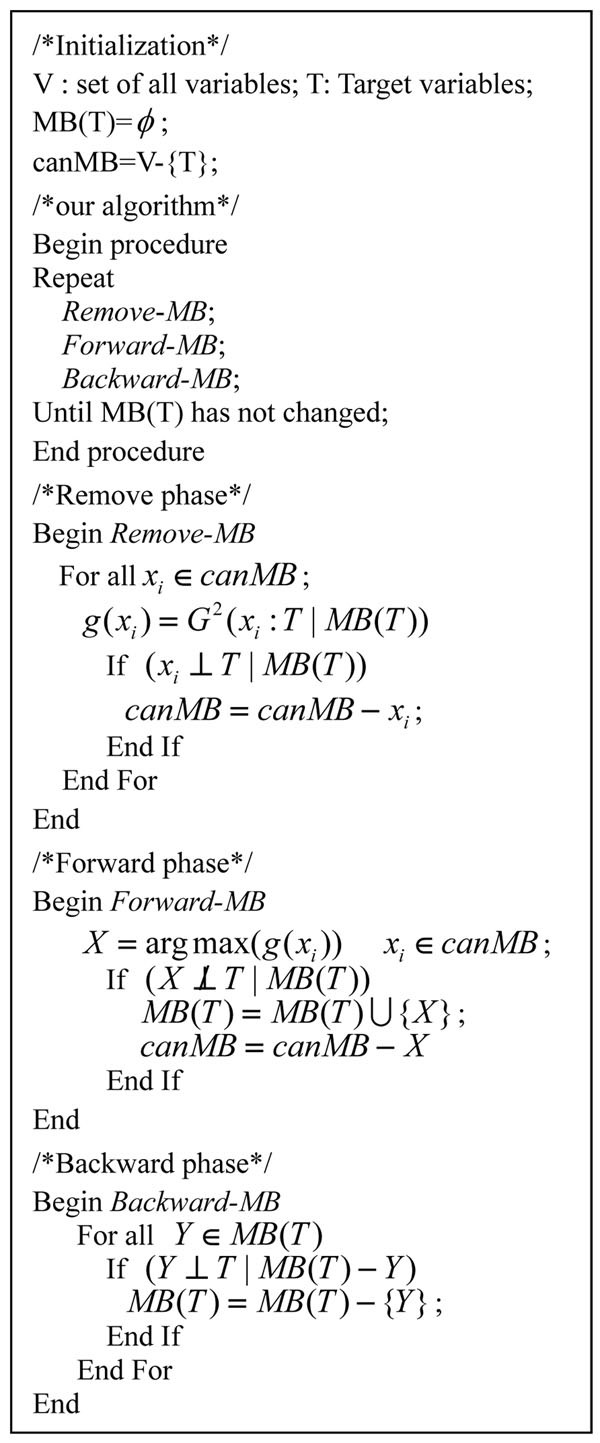
FEPI-MB algorithm.